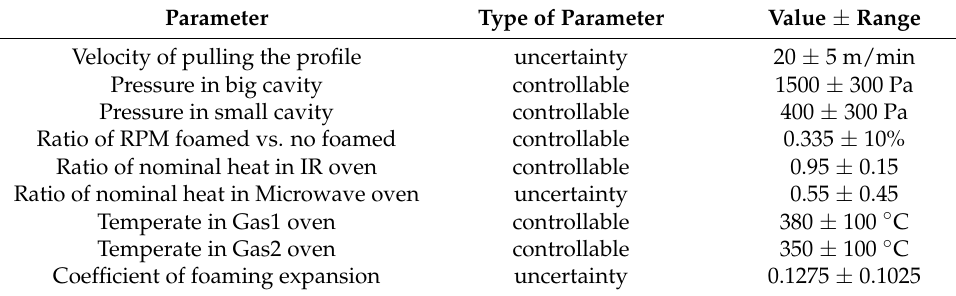
Table 1. Parameters of the FE model.